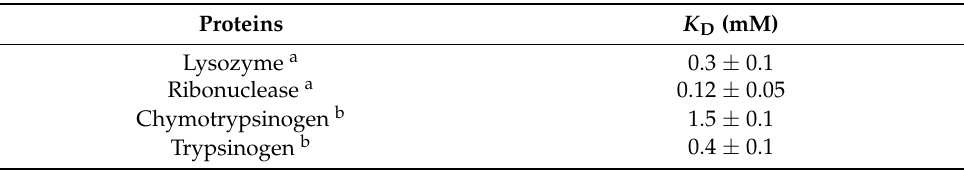
Table 1. Values of K D for Protein-GSSG